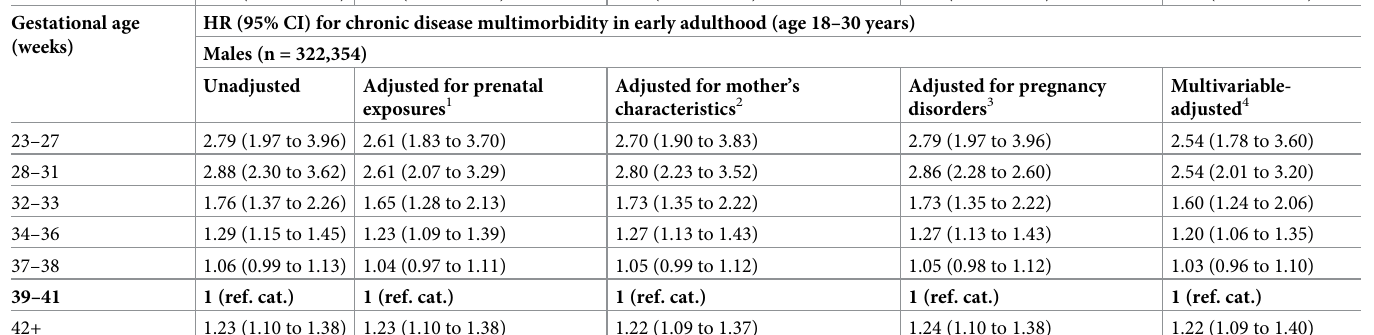
1 Birthweight z-score (continuous), multiple pregnancy (yes vs. no) and congenital anomalies (yes vs. no) 2 2 Mother’s age (years, continuous), parity (0, 1, 2, 3, 4, 5+), smoking during pregnancy (yes vs. no) and socioeconomic position (low, intermediate, high, not known) 3 Adjusted for mother’s diabetes (none, gestational diabetes, type 1/type 2 diabetes) and mother’s hypertension during pregnancy (yes vs. no) 4 Adjusted for all above